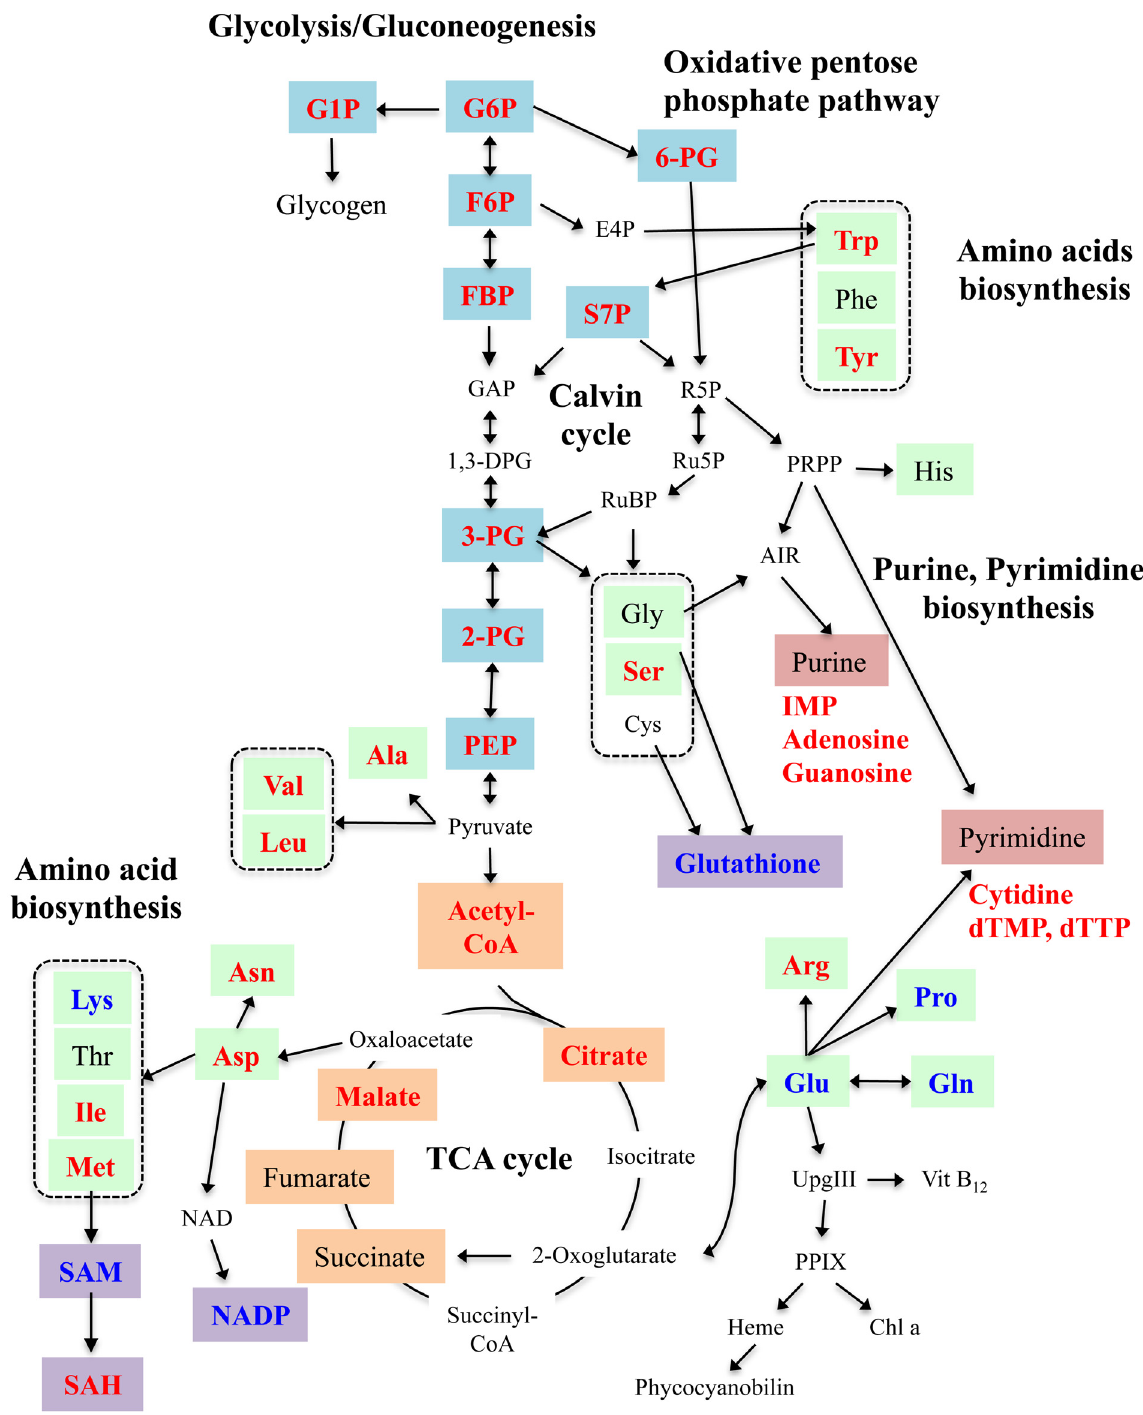
Fig 5. Schematic diagram of central metabolism in Synechococcus 7942. The metabolites measured in Fig 4 are highlighted in blue (glycolysis), orange (TCA cycle), green (amino acids), red (purine and pyrimidine), and purple (others: NADP + , SAM, SAH, and glutathione). The metabolites that increased ( > 2) or decreased ( < 0.5) during lag phase (3 hr or 9 hr after transfer), relative to the amount in the starting culture, are denoted in red and blue fonts, respectively.